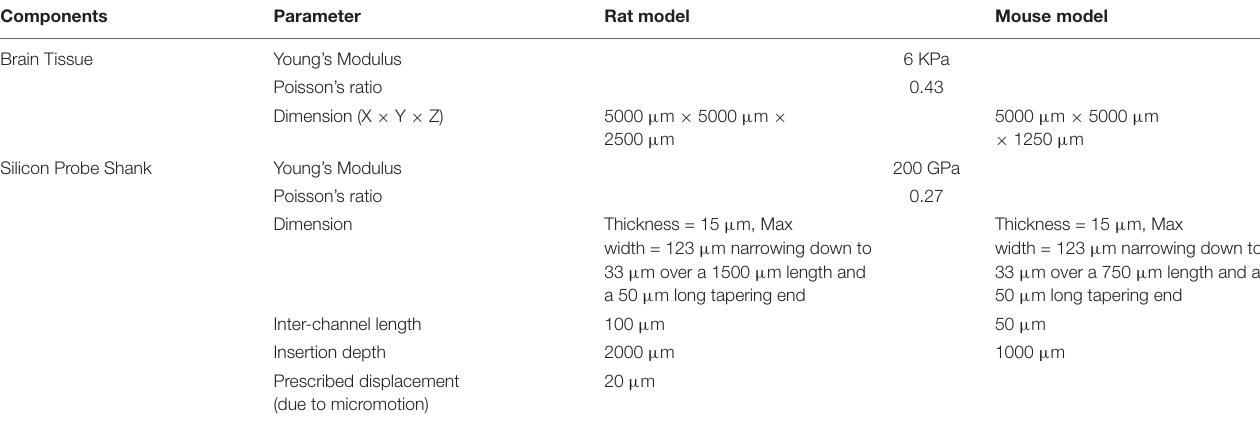
TABLE 1 | Parameters used in the finite-element models to simulate micromotion and strain from implanted silicon probe shank in rat and mouse brain.